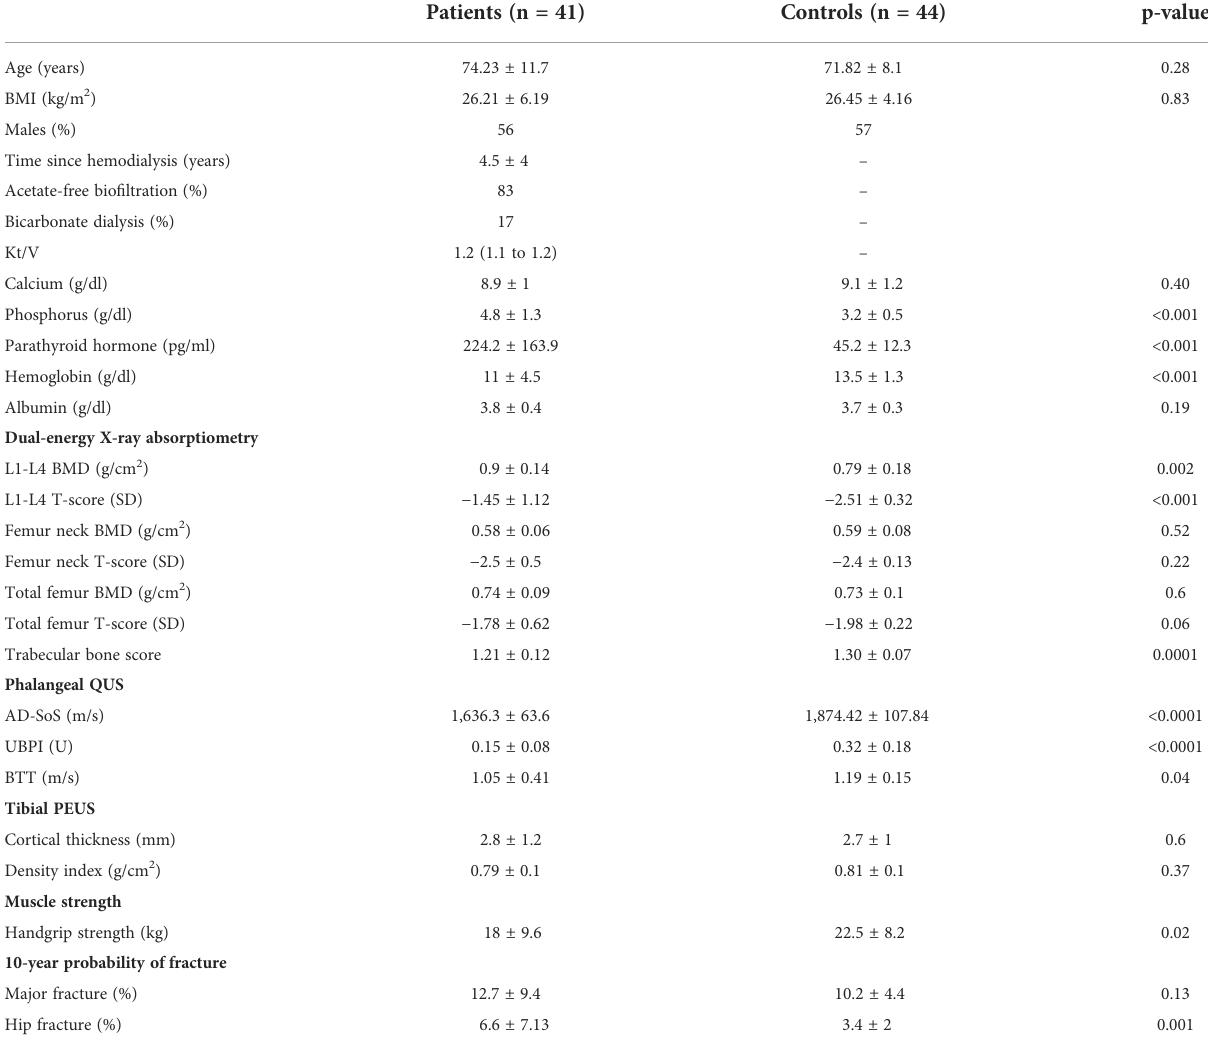
TABLE 1 Main clinical features of hemodialysis patients and